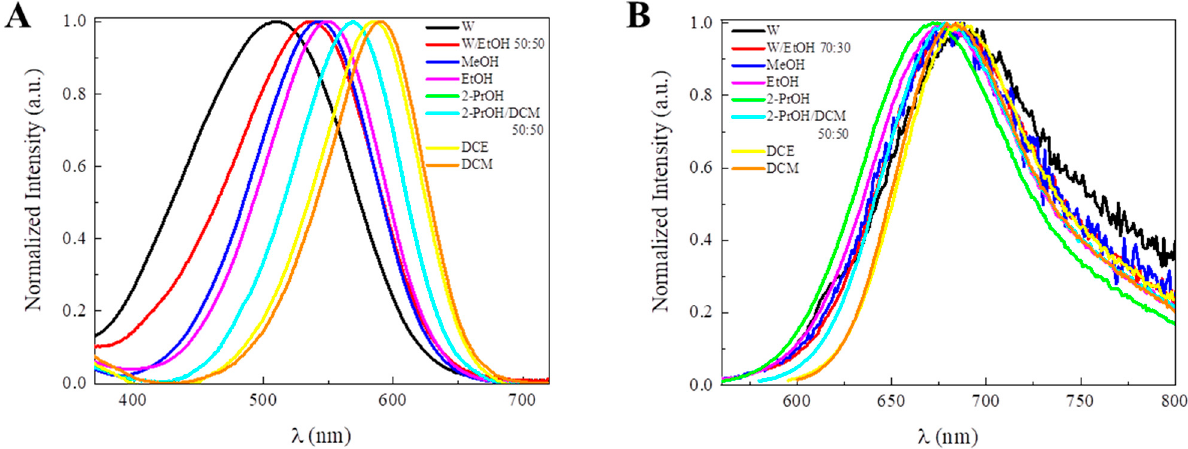
Figure 1. Absorption ( A ) and emission ( B ) spectra of compound pQ- π 2 in solvents of different polarity. (W—water; EtOH—ethanol; MeOH—methanol; 2-PrOH—2-propanol; DCE—1,2-dichloroethane;